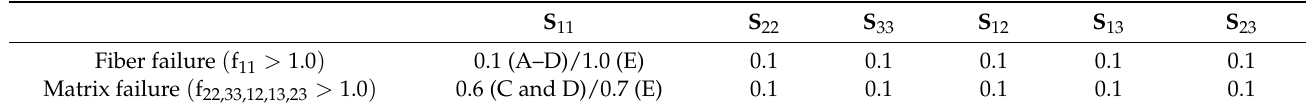
Table 5. Stiffness reduction factors for Model C, D, and